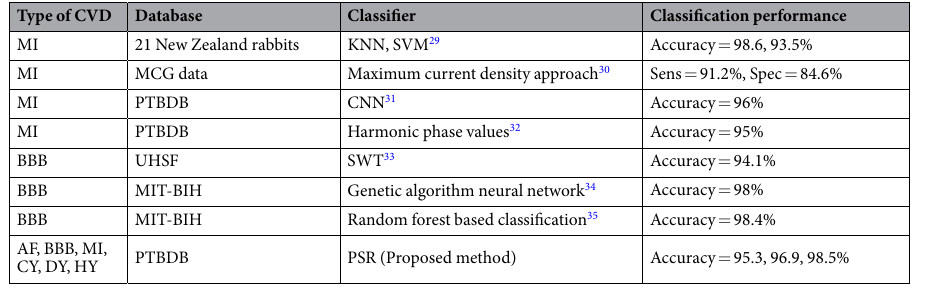
Table 3. Performance comparison with the existing methods. * MCG = (magnetocardiography), UHSF = University Hospital Southampton NHS